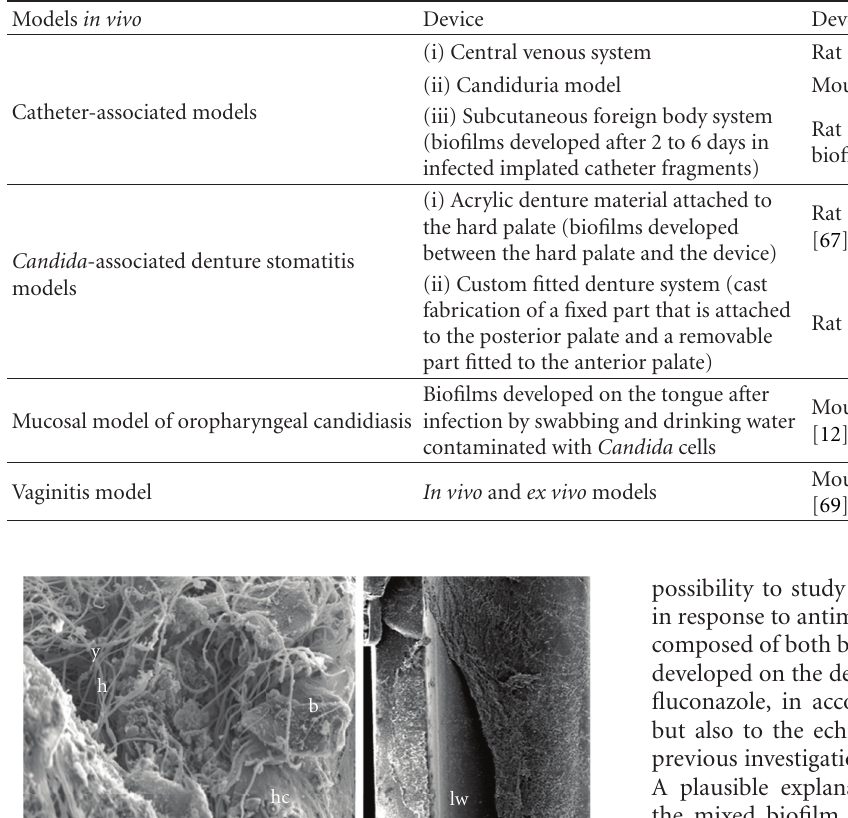
Table 2: Candida biofilms in vivo models.